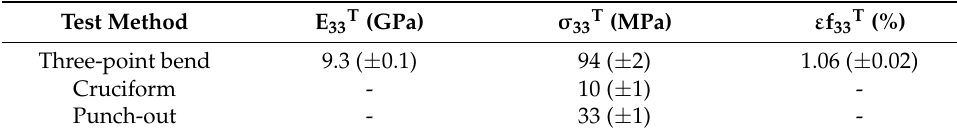
Table 5. T-T tensile properties determined from the testing of indirect geometries.